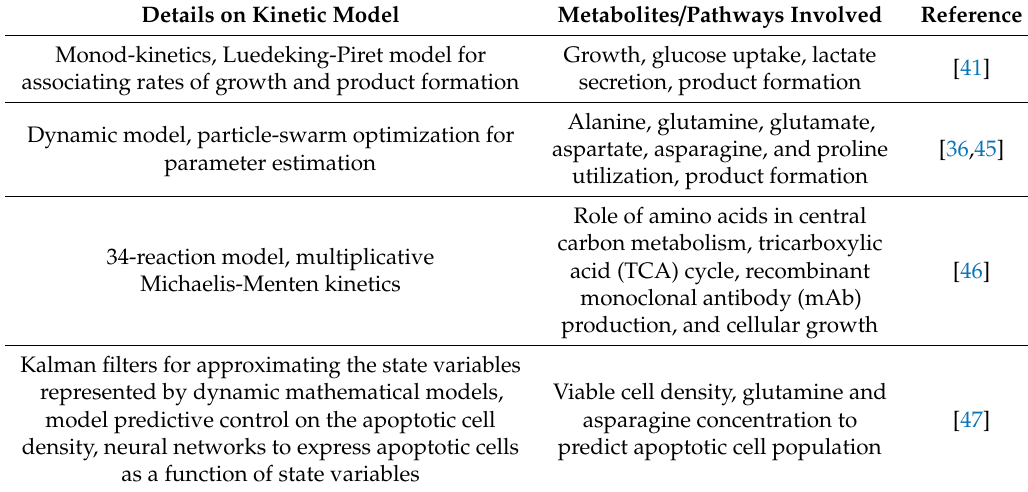
Table 1. Summary of the available kinetic model-based approaches employed in recombinant protein-producing CHO cell medium development and